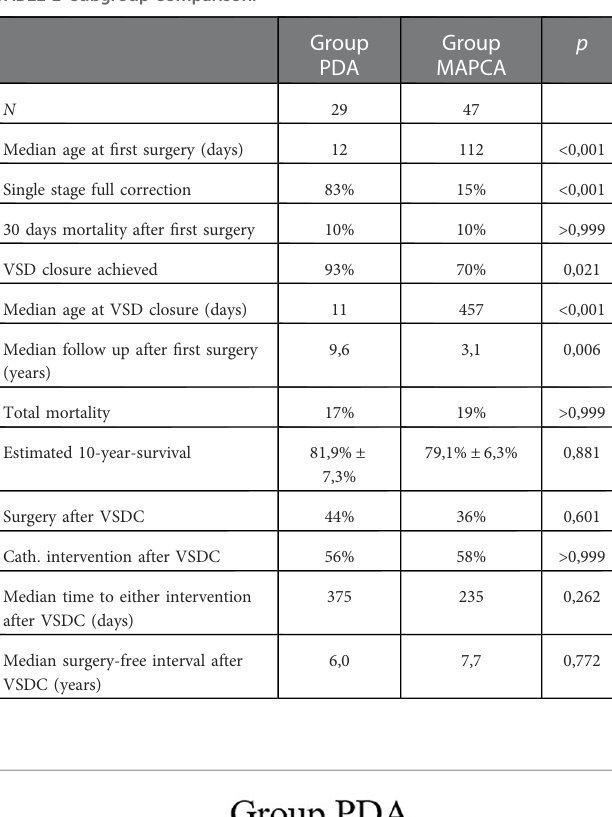
TABLE 1 Subgroup comparison.